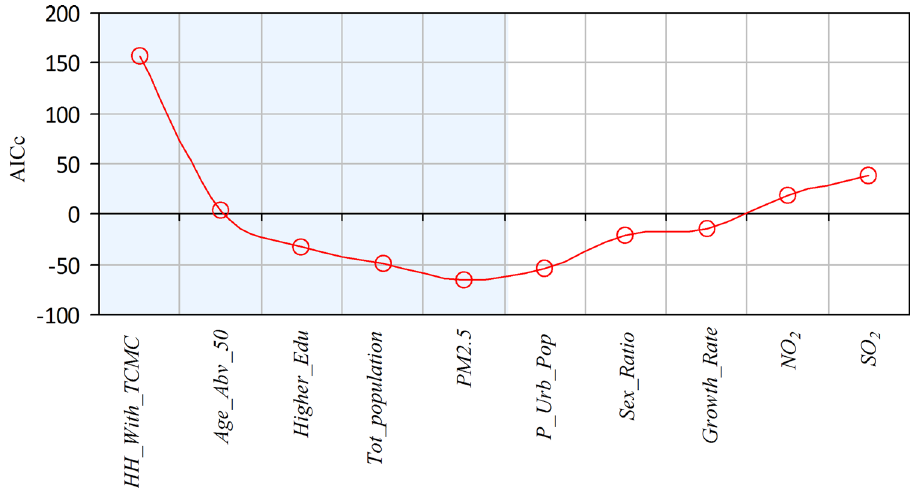
Figure 2. Stepwise variable selection for geographically weighted regression (GWR).